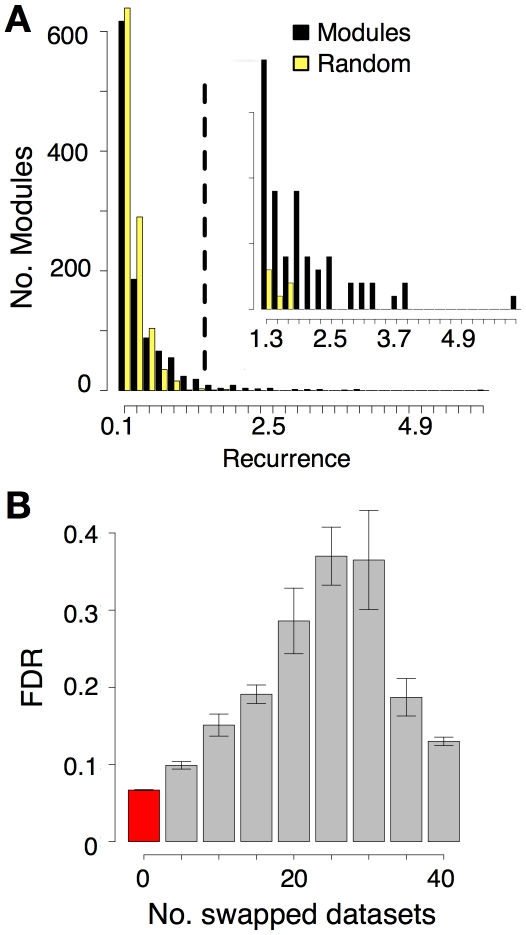
Gene modules exhibit significantly recurrent expression across diverse stem cells.(A) Recurrence score distribution compared to a background control. All modules of size 3 (1098 modules: 1091 homolog modules and 7 functional modules; black), compared to randomized families of size 3 based on 1000 random permutations of the original data (yellow). Similar results were obtained for modules of other sizes (Figure S2e–g). (B) Swap experiment. An increasing number of SGLs were replaced by their corresponding DGL and used to calculate recurrence for all modules. For several swap proportions (x-axis) the average FDR (y-axis) of the computed recurrences was plotted (gray bars) and compared to the distribution obtained without swapping (red bars). Error bars depict one standard error.